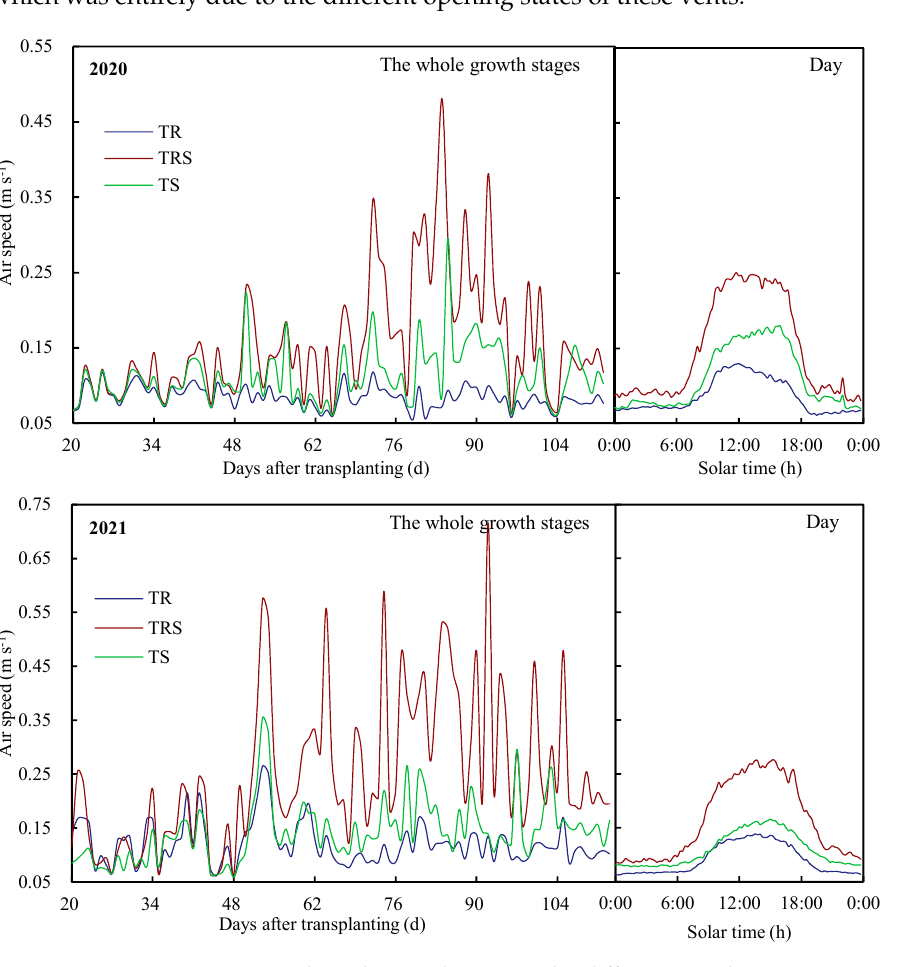
Figure 1. Variations in air speed inside greenhouses under different ventilation treatments in 2020 and